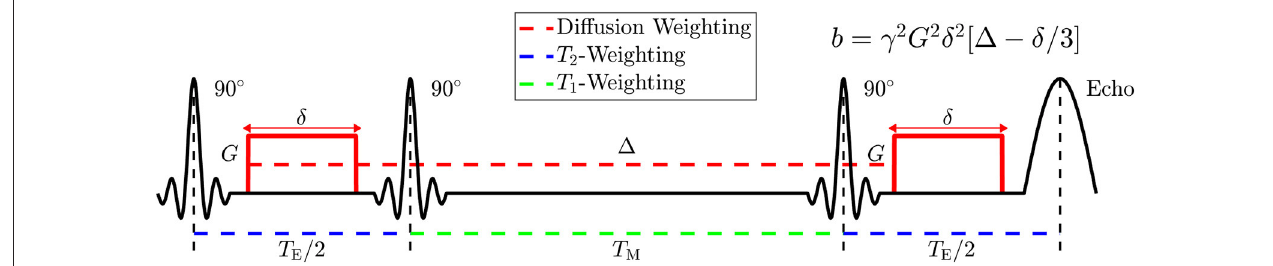
FIGURE 3 | Diagram of the Stimulated Echo Acquisition Mode (STEAM) sequence showing how to manipulate parameters of NMR relaxometry ( T 2 and T 1 ) by varying the echo time, T E , and the mixing time, T M ; and how to manipulate parameters of diffusion weighting by varying the applied gradient amplitude, G , the applied gradient duration, δ , and the spacing 1 between applied gradients. The diffusion time t is approximately given by 1 ; the accuracy in its definition is set by the value of δ , cf. section 2.3 of Novikov et al.